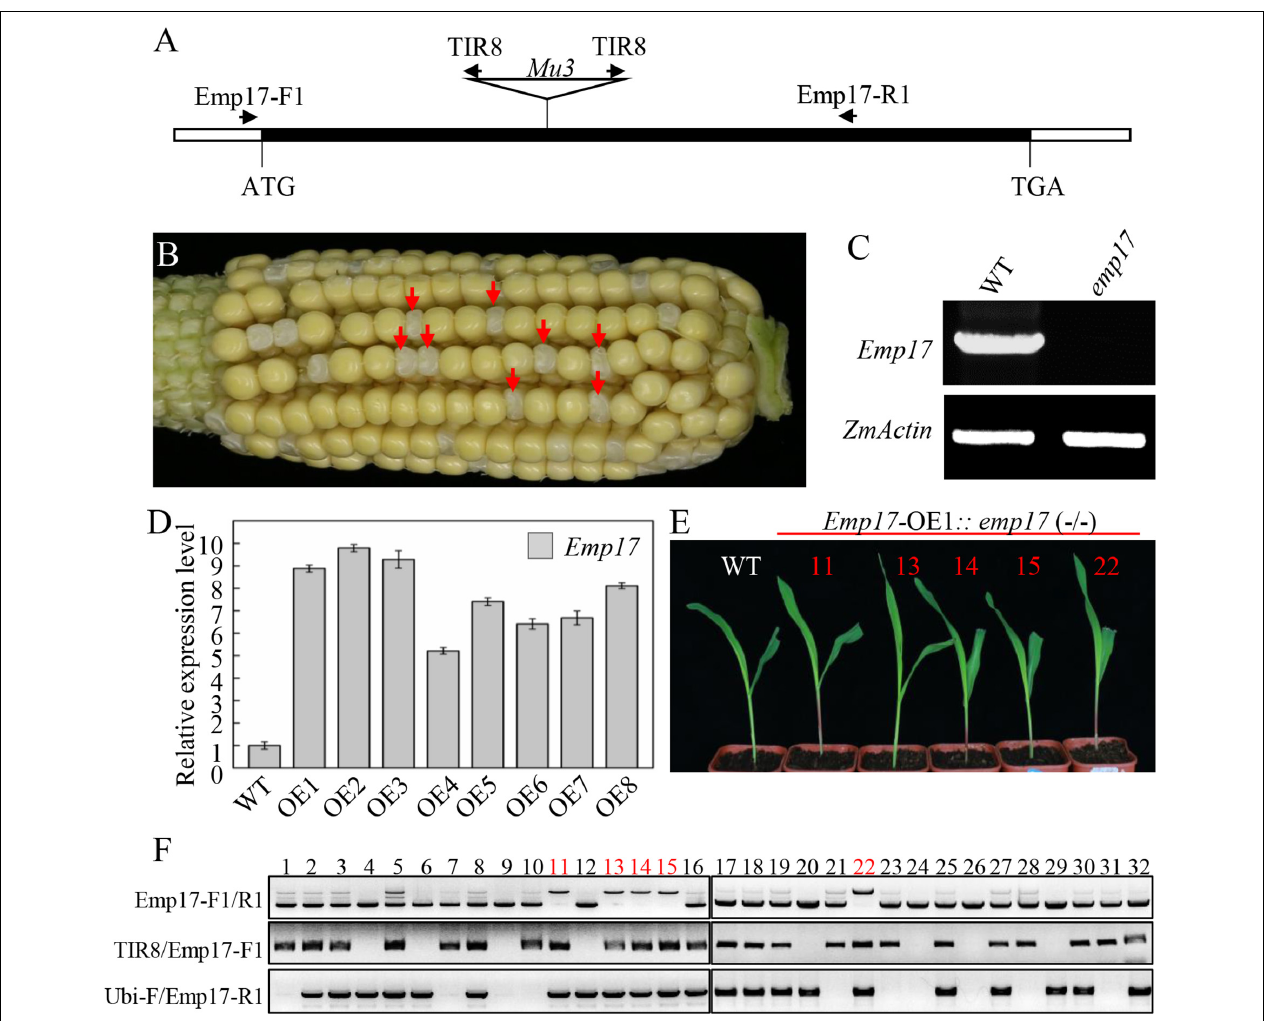
FIGURE 2 | Mutation of Emp17 arrests maize embryogenesis and endosperm development. (A) The gene structure of Emp17 . The Mu transposon insertion was marked by a triangle. (B) A selfed ear of the emp17 heterozygous plant. The empty pericarp kernels ( emp17 ) are marked by red arrows. (C) RT-PCR analysis of Emp17 transcription profiling in wild type and emp17 . (D) The expression profiles of Emp17 in wild type and Emp17 overexpression plants. (E) The phenotype of Emp17-OE1 : emp17 (–/–) and wild type (WT) seedlings. (F) Genotype analysis of seedlings. The bands amplified by PCR using TIR8/Emp17-F1 primers indicate the Mu insertion in Emp17 . The bands amplified by PCR using Ubi-F/Emp17-R1 primers indicate Emp17 transgenic plants. The bands amplified by PCR using Emp17-F1/R1 primers indicate Emp17 gene containing a Mu insertion (the longer bands) in the Emp17-OE1 : emp17 (–/–) seedlings, and the wild type Emp17 gene (the shorter bands) in emp17 ( + / − ) and WT,